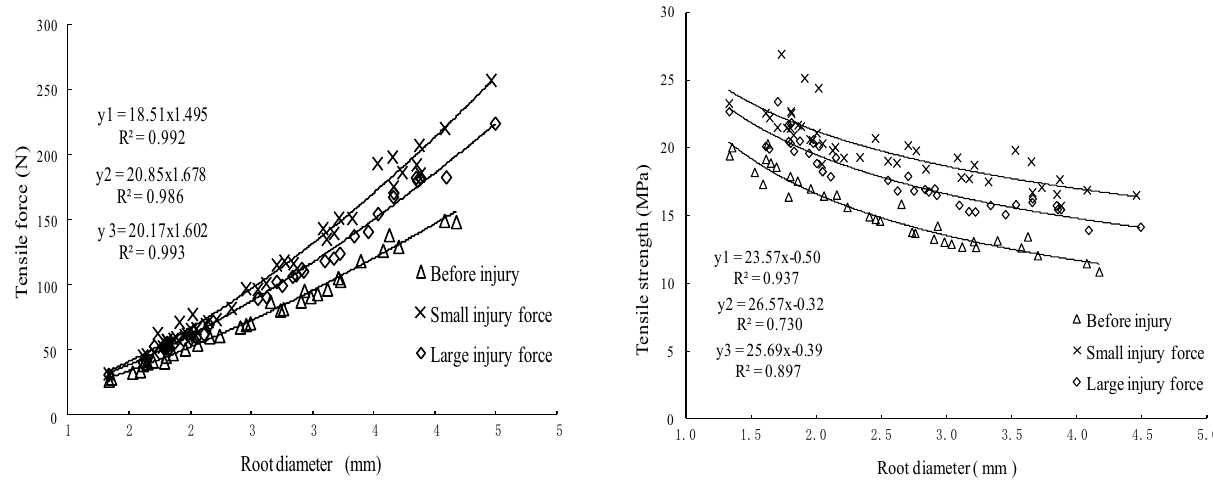
Figure 4. The differences in tensile ability of Salix psammophila roots after self-repair and that of before injured.